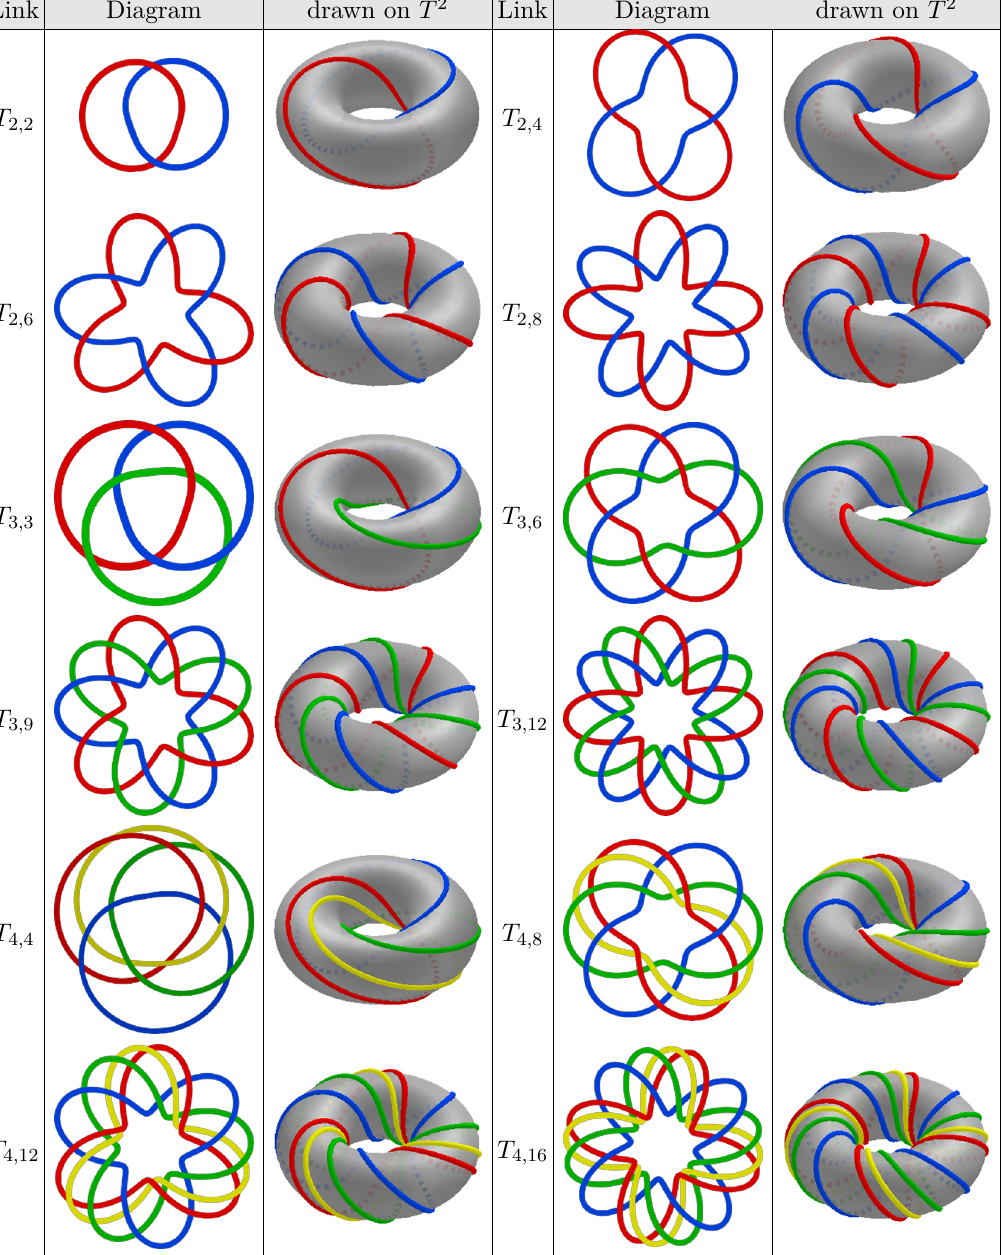
Table 1. Torus links of type T p,pn